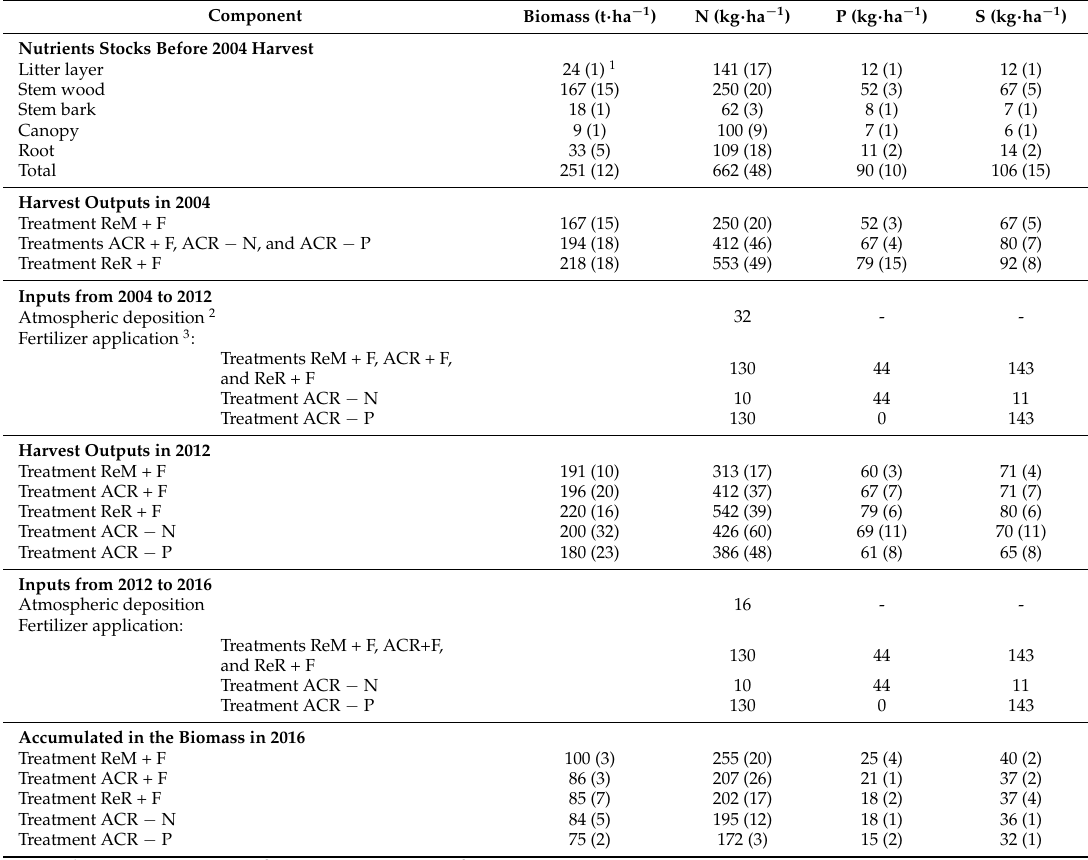
Table 3. Nutrient stocked in the forest biomass, inputs, and outputs of nutrients in two crop